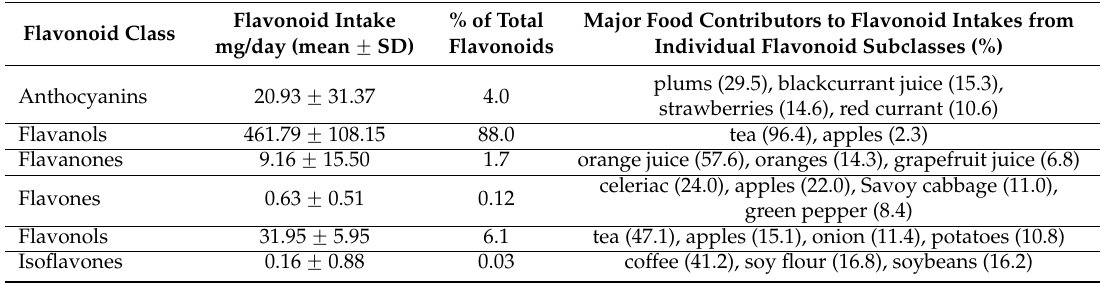
Table 4. Dietary flavonoid intakes calculated with the USDA database * and their major food contributors ( n =